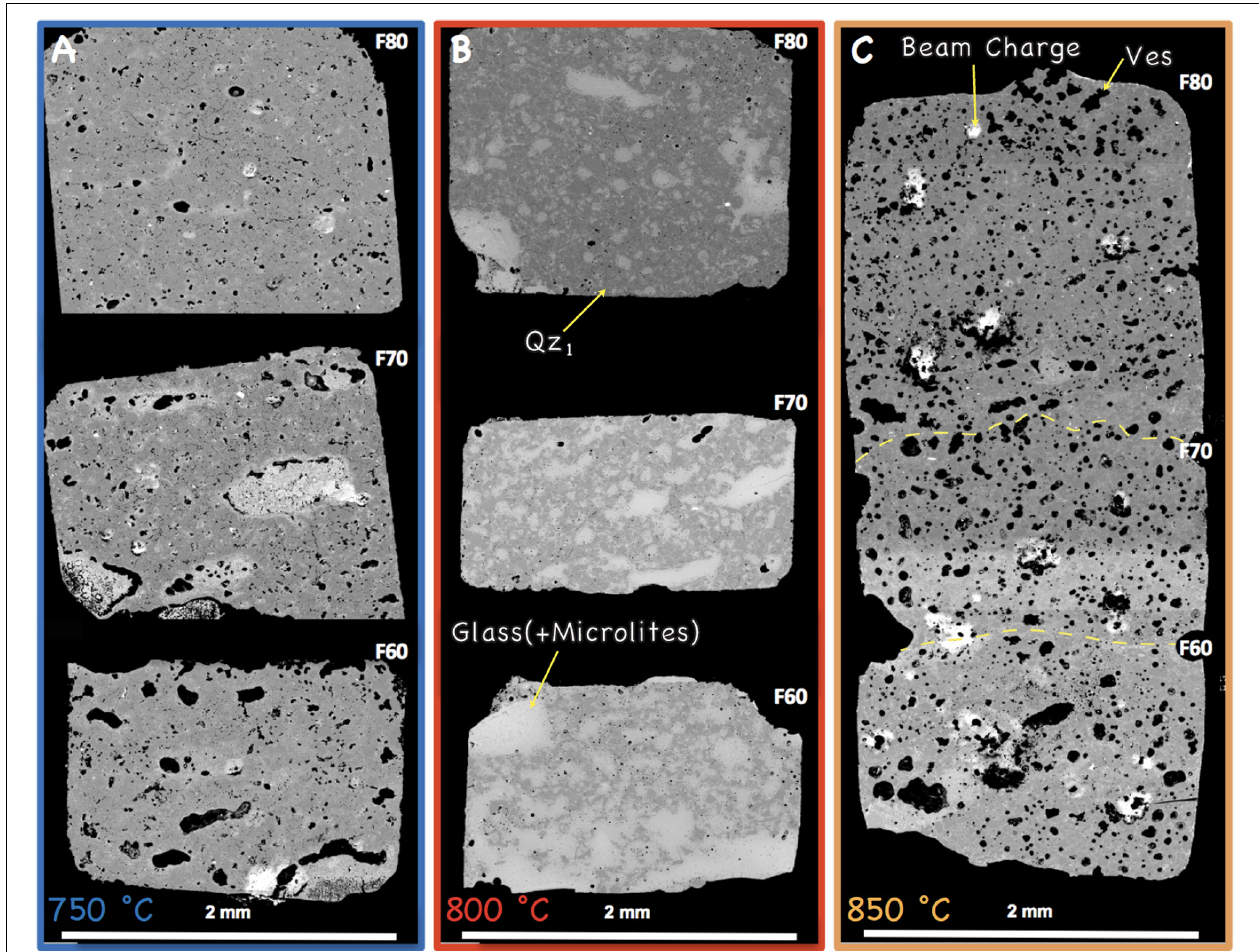
FIGURE 3 | FEG-probe-based BSE images of central sections of all crystal-bearing samples from experiments at: (A) 750, (B) 800, and (C) 850 ◦ C. Yellow dashed lines divide the domains of run products F60, F70, and F80 after the experiment run at 850 ◦ C. See acronyms from Figure 2